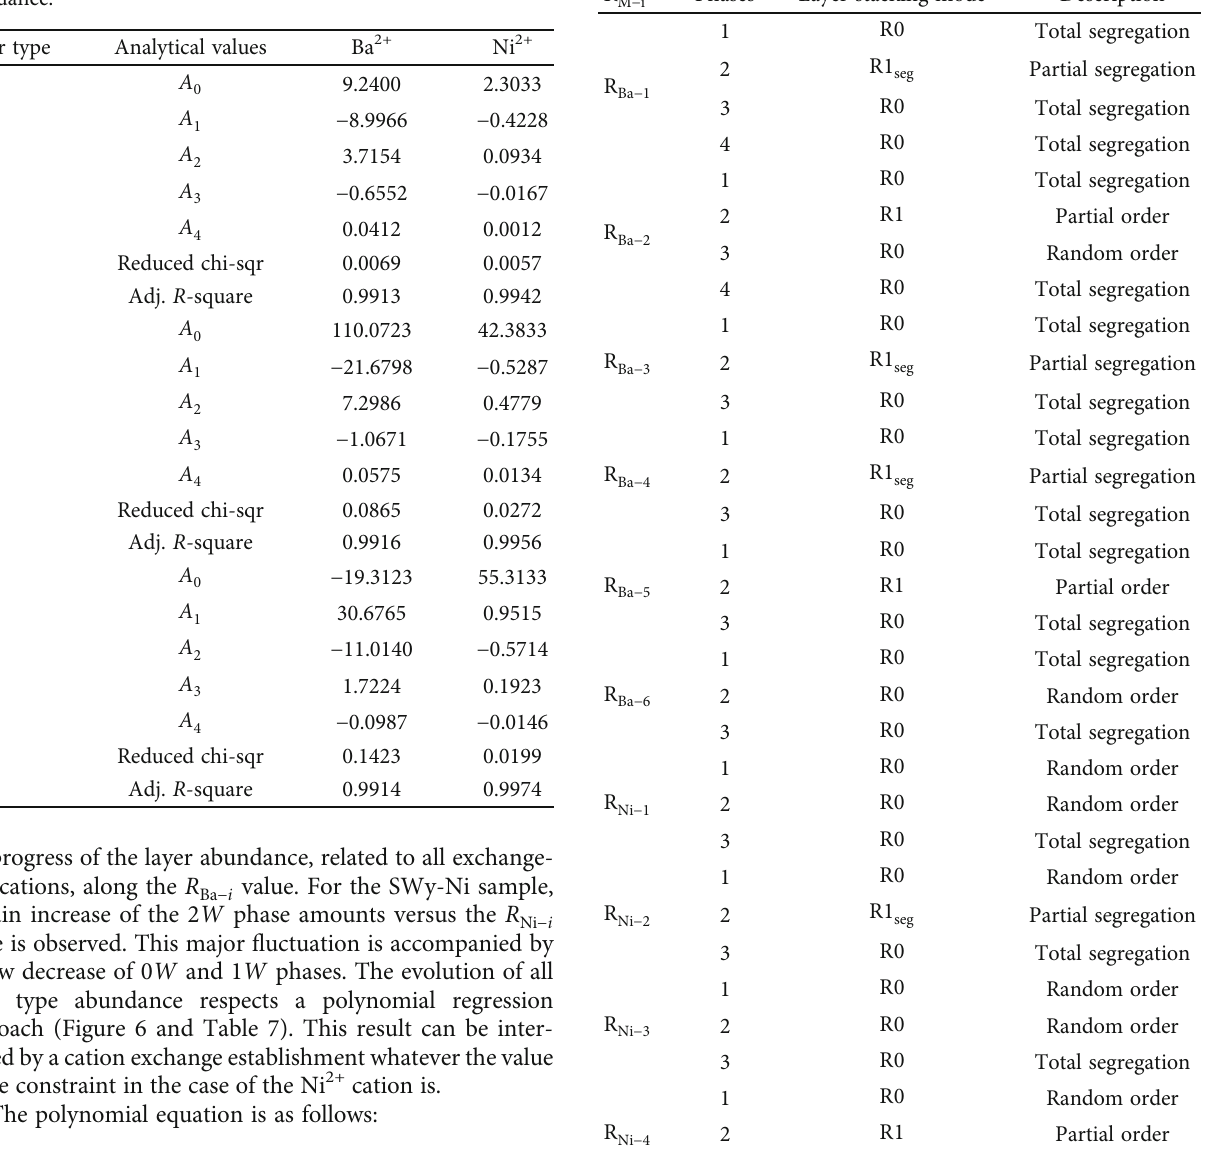
Table 8: Layer stacking mode versus the R